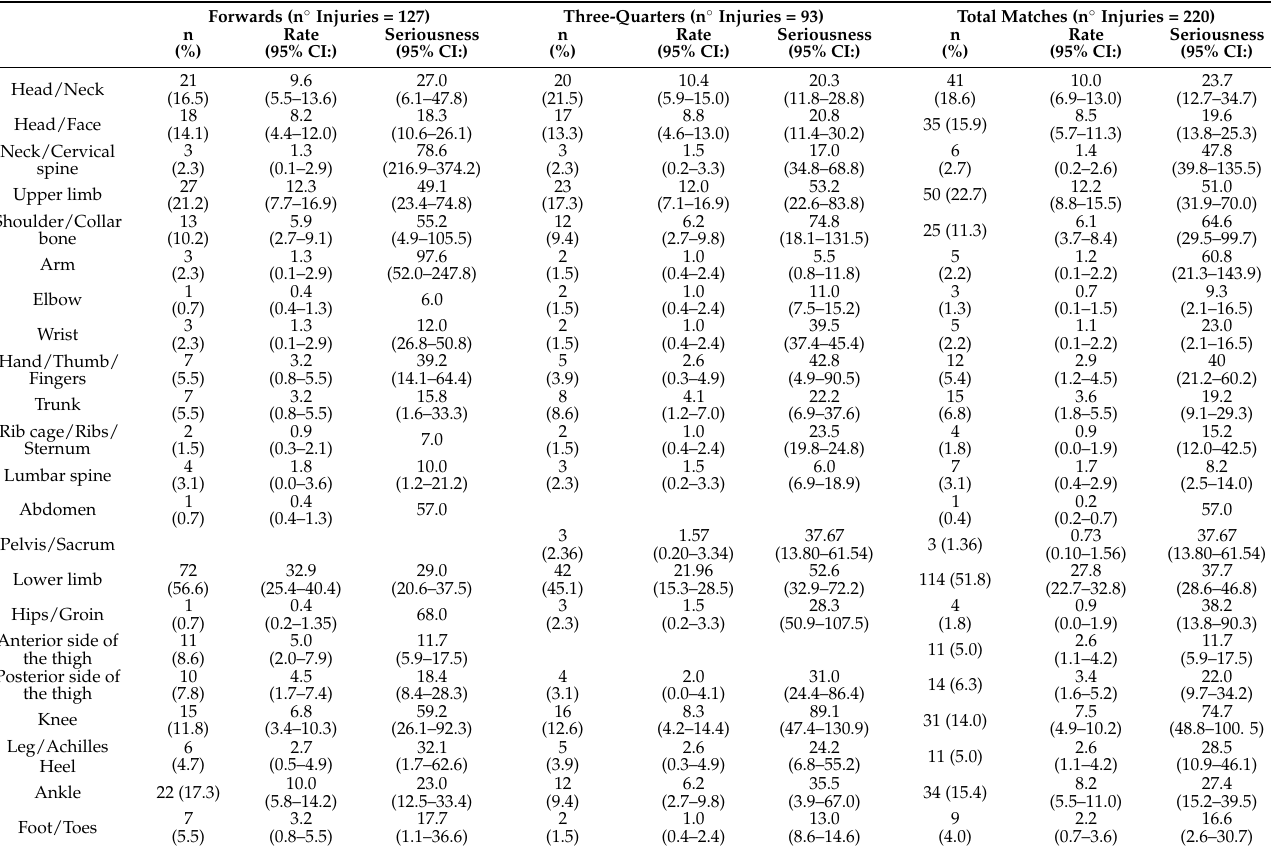
Table 3. Rate and seriousness of the match injuries distributed